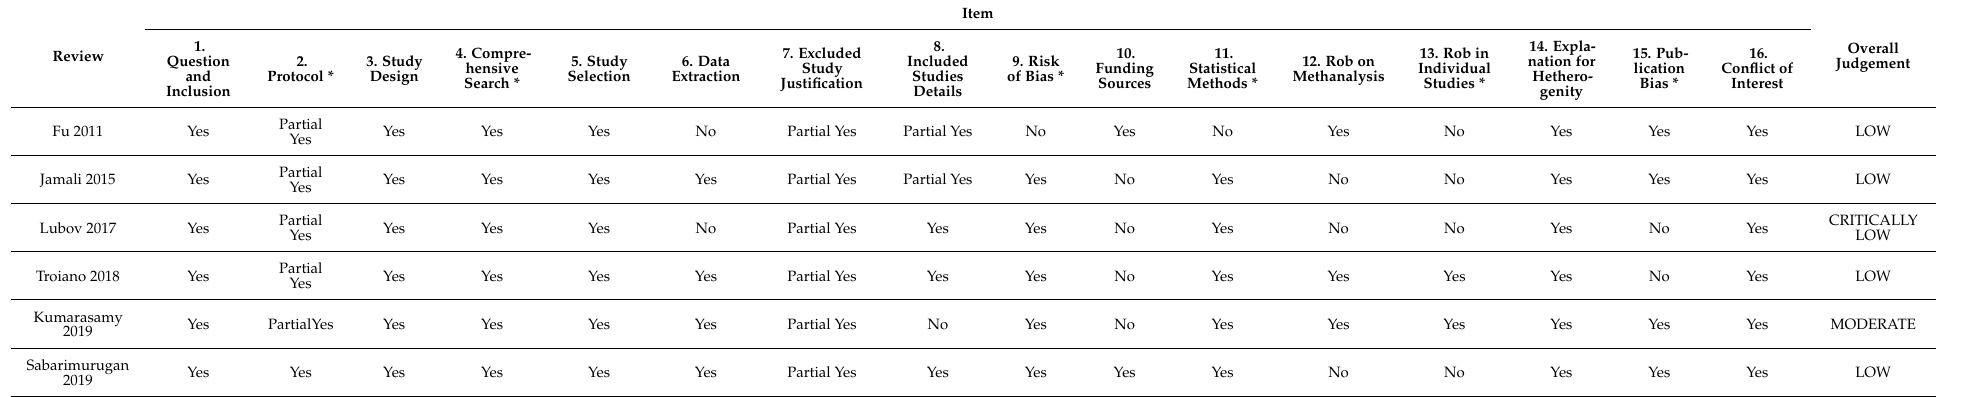
Table 1. Quality Assessment of the included reviews using the AMSTAR-2 checklist. Items with * represent the critical domains.